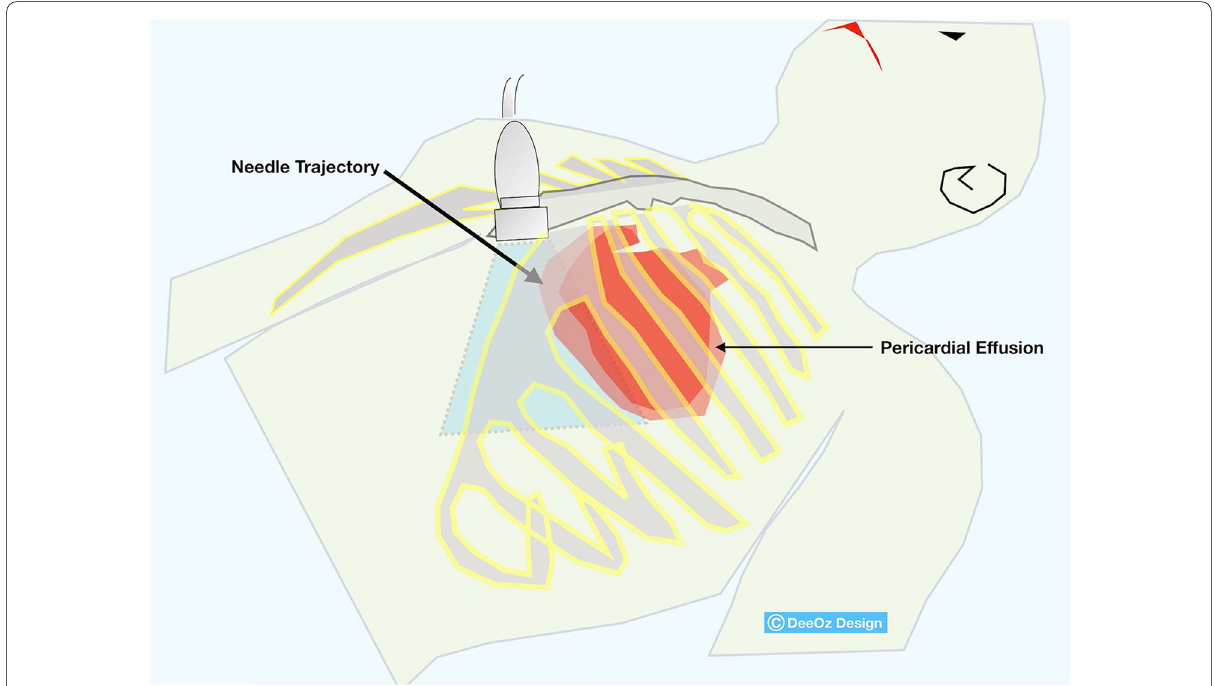
Fig. 1 High-frequency linear ultrasound transducer was placed horizontally at subcostal area with the marker pointing